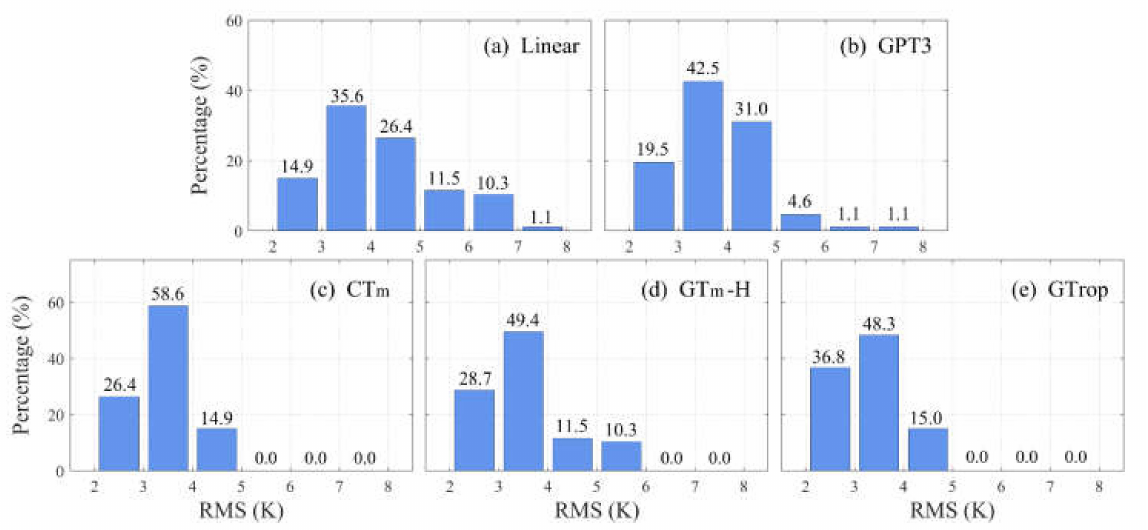
Figure 10. Percentage of RMS in different intervals calculated by the five T m models at 87 RS stations over the period of 2011 to 2020.